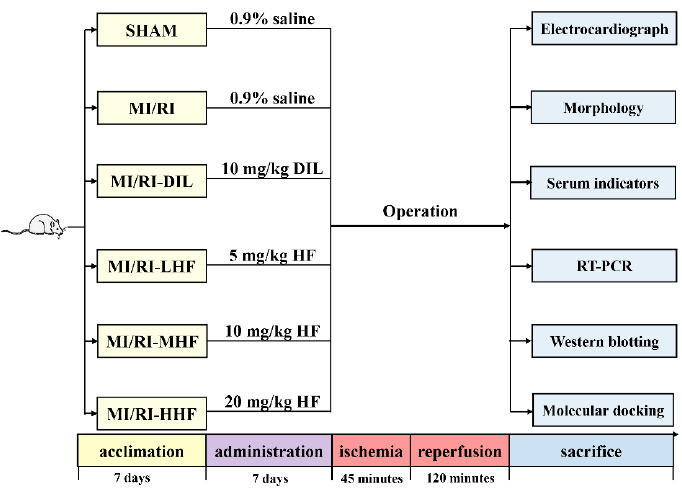
Figure 1. The design of this